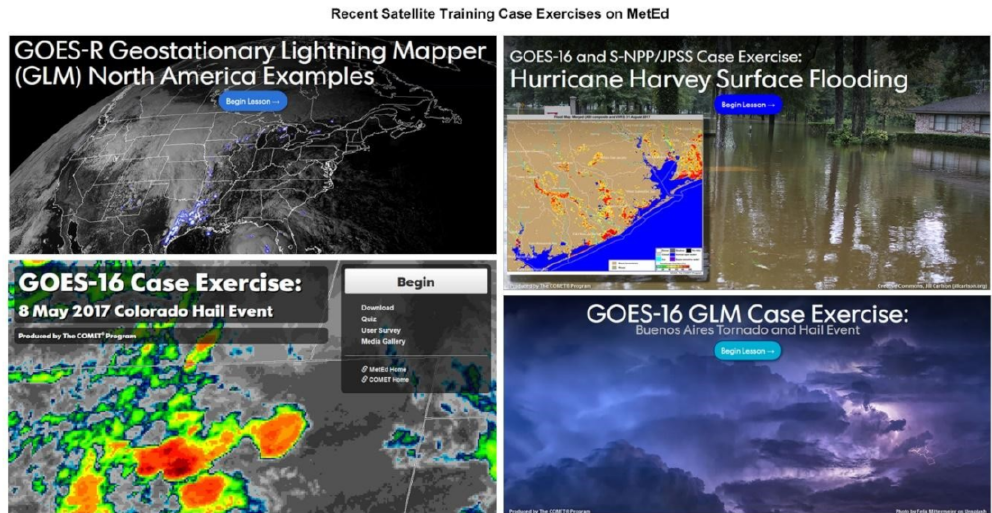
Figure 8. Title page screenshots for four recent event-focused satellite training lessons on